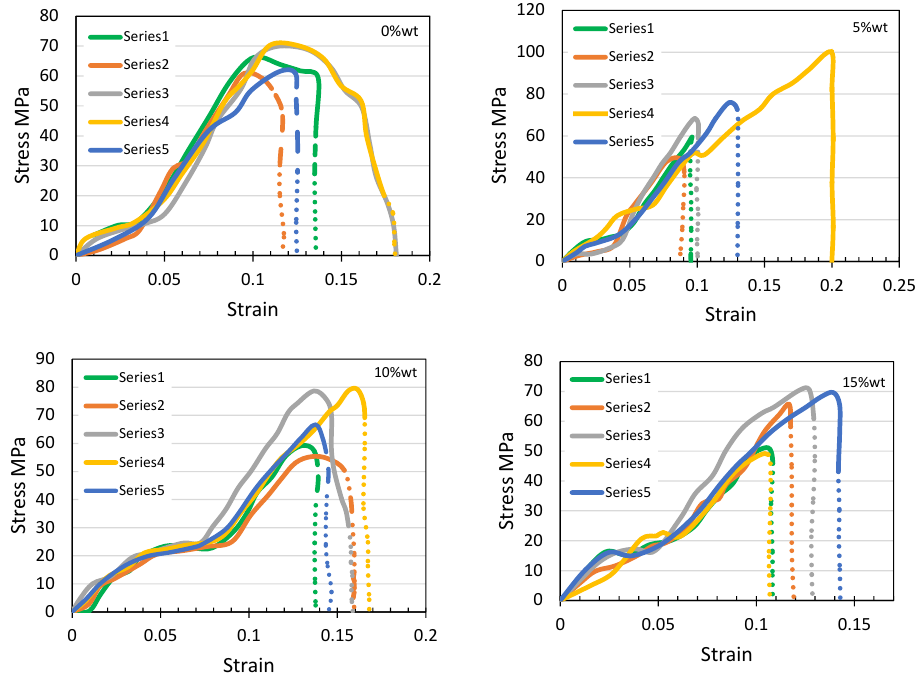
Figure 10. Stress-strain plot of the four composite blends.